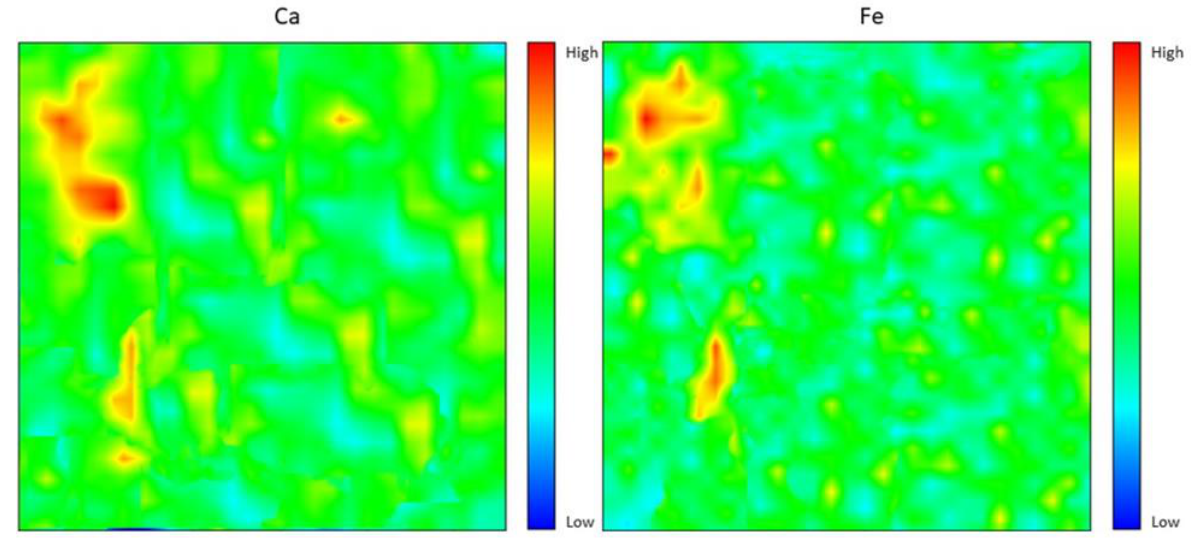
Figure 10. Ca and Fe elemental distribution for 8 M of NaOH fly ash/dolomite geopolymer.